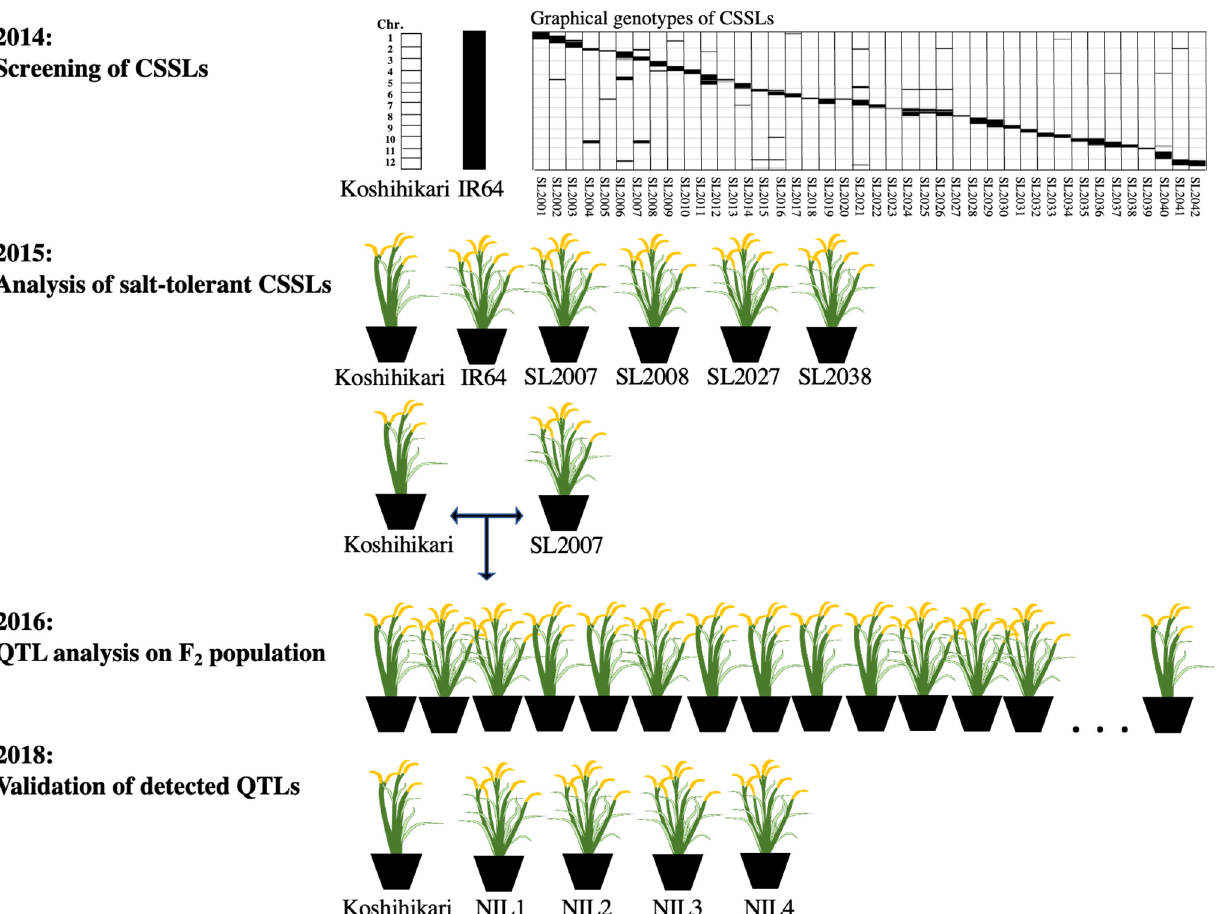
Figure 1. Schematic representation of the experimental design.